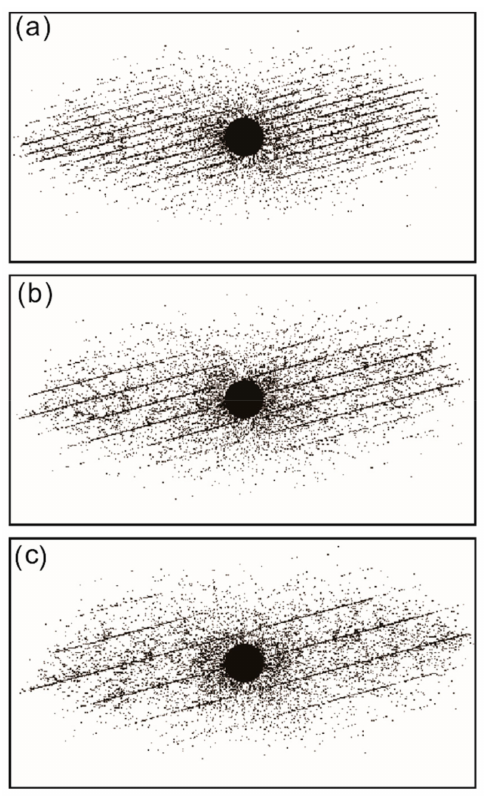
Figure 13. Distribution of fractures for di ff erent structural plane spacings with a structural plane orientation of 15 ◦ . The boundary stress and injection rate were the same as with the base model. ( a ) Bedding spacing is the same as the hole radius ( d = r ); ( b ) Bedding spacing is two times of the hole radius ( d = 2 r ); ( c ) Bedding spacing is two times of the hole radius ( d = 3 r